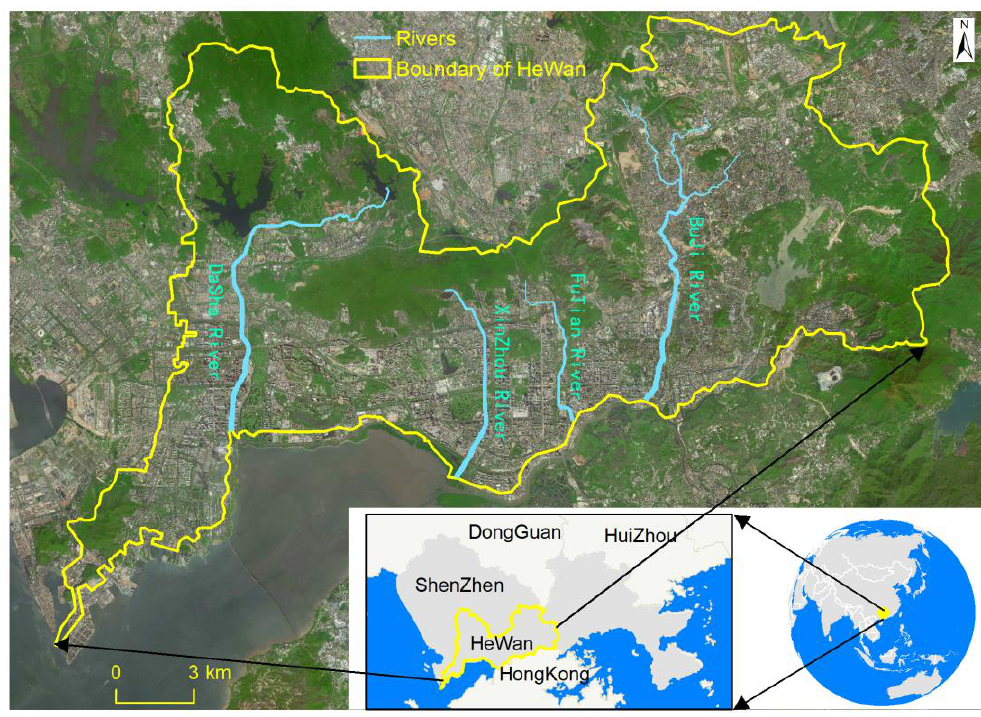
Figure 2. Location of the four rivers.